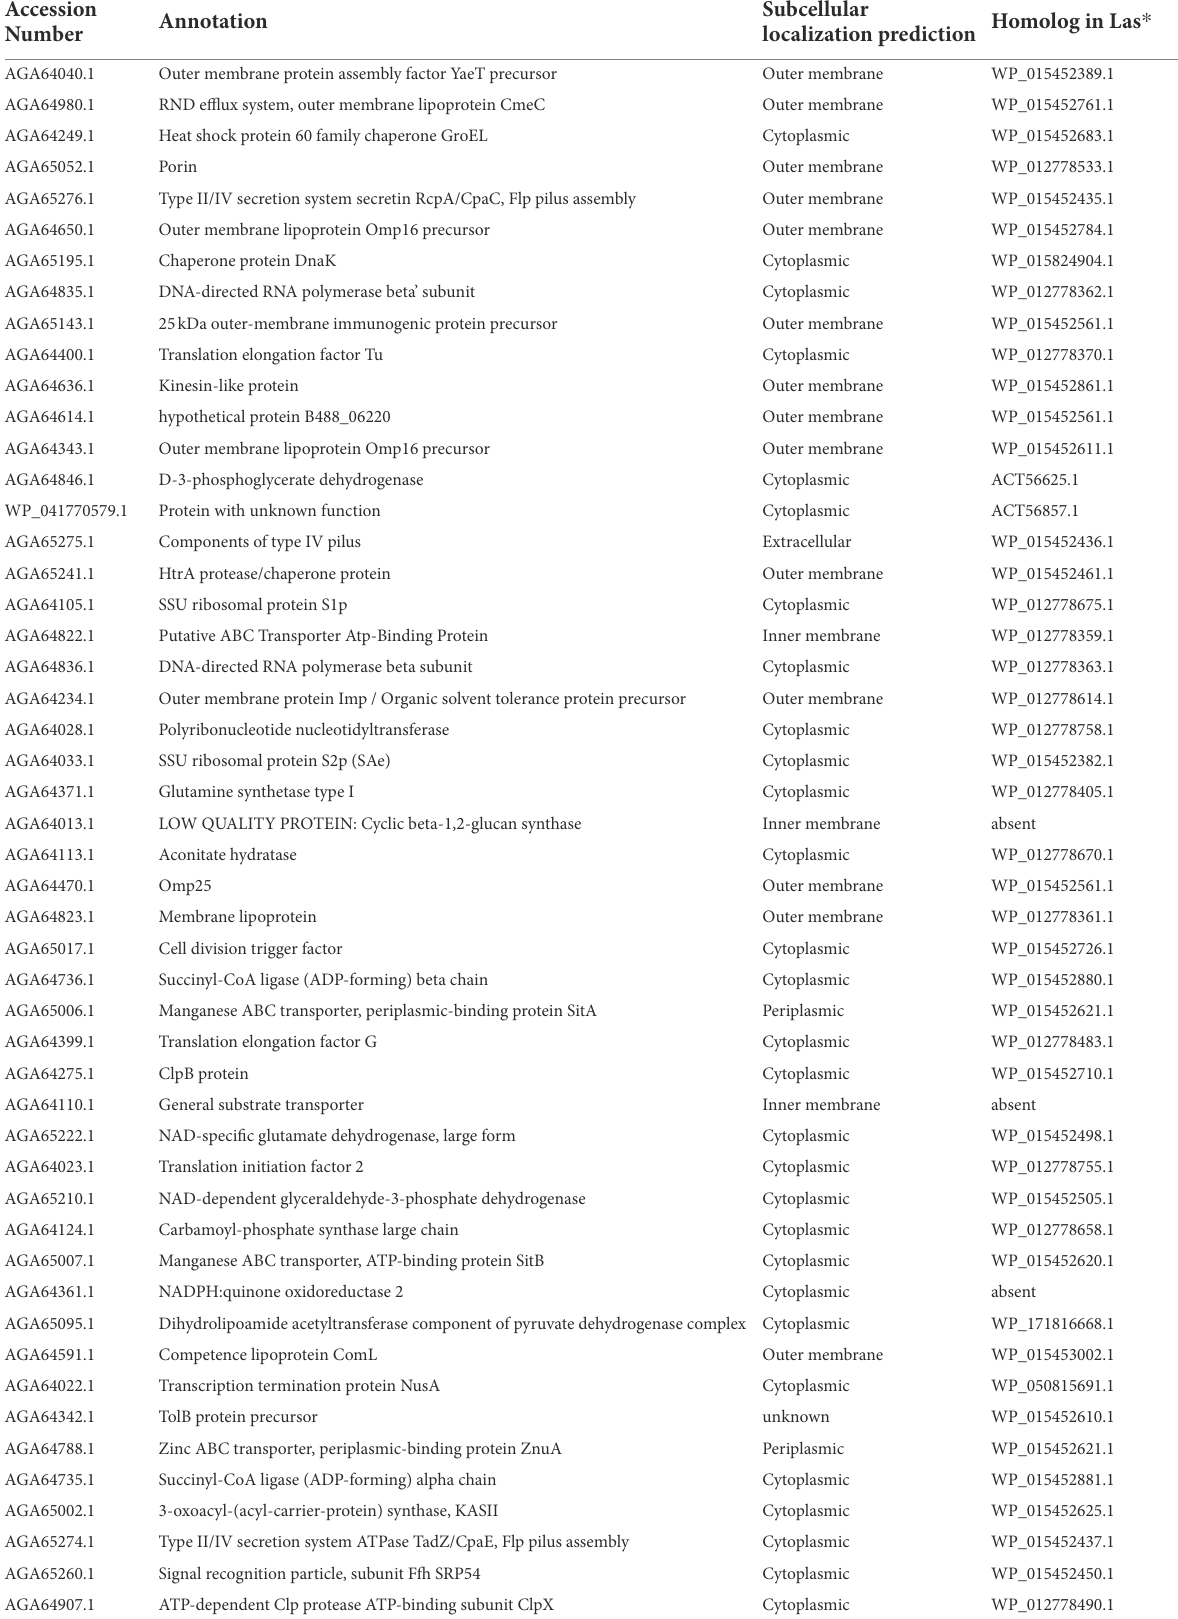
TABLE 1 Proteins identified from Liberibacter crescens BT-1 outer membrane